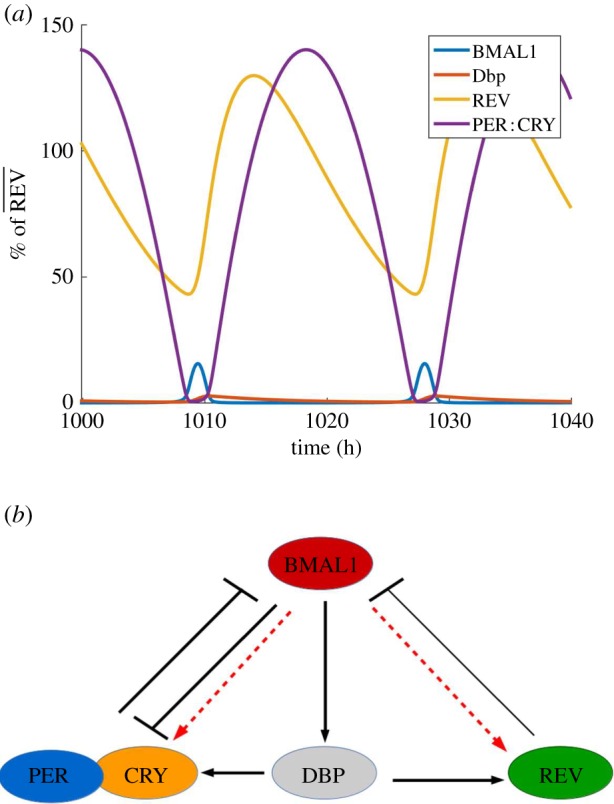
The reduced model can recover the main properties of the circadian clock. (a) Output of the reduced model, oscillations have a period of 18.6 h with parameters of table 2; BMAL1 and PER : CRY maintain an antiphasic oscillation. (b) A scheme of the reduced model. Red dashed arrows show the effect of Eboxes on REV and PER : CRY and can be removed.